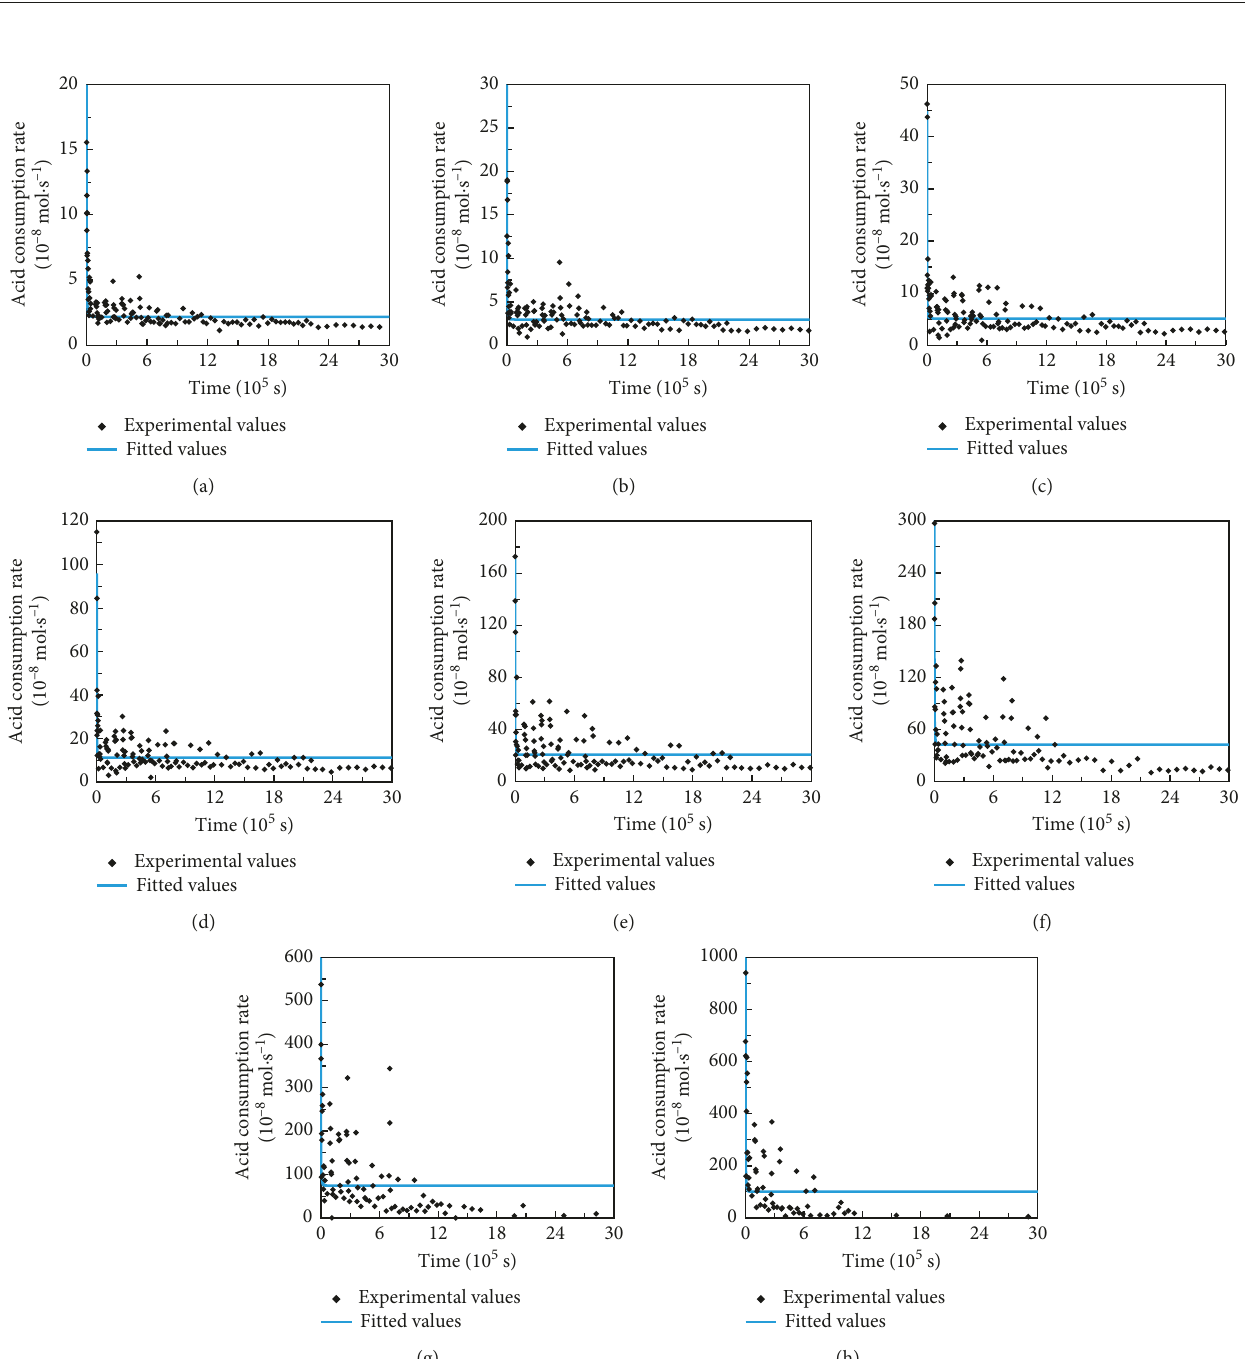
Figure 6: Comparison of the experimental and fitted values of acid consumption rate. (a) pH � 4.00, w / c � 0.40. (b) pH � 3.70, w / c � 0.50. (c) pH � 3.40, w / c � 0.60. (d) pH � 3.10, w / c � 0.70. (e) pH � 2.80, w / c � 0.35. (f) pH � 2.50, w / c � 0.45. (g) pH � 2.20, w / c � 0.55. (h) pH � 2.00, w / c �